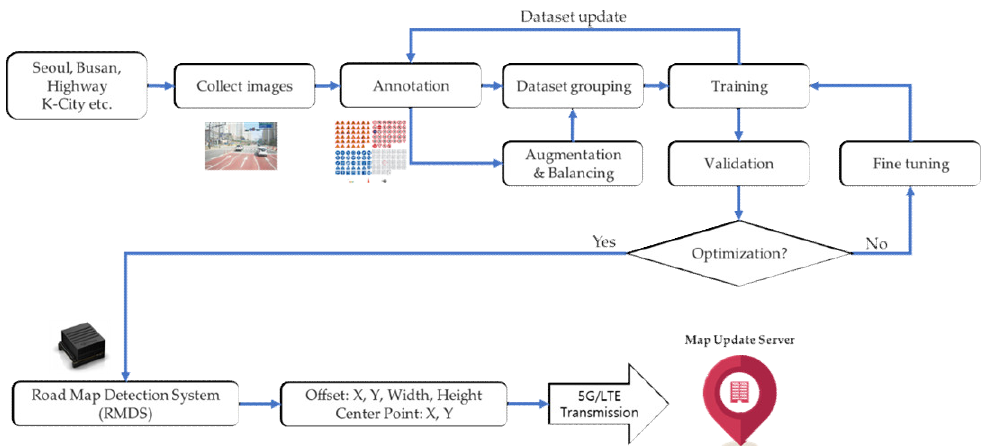
Figure 13. Augmentation test (first column, original image): ( a ) contrast (daytime), ( b ) contrast (night), ( c ) translation, ( d ) affine, and ( e ) random erase.